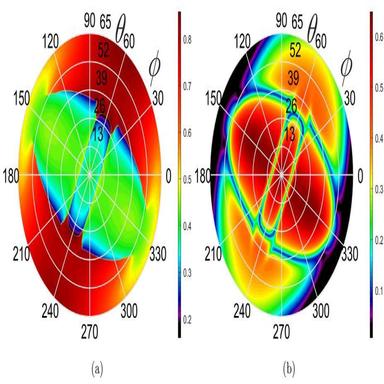
TOF P-UPS plot(a) and amplitude P-UPS plot(b) corresponding to a measurement on a unidirectional 4 C/E plate (d = ± 1.200 0.006 mm). The TOF colorbar is represented in μs. The amplitude colorbar is normalized to the maximum amplitude of the input signal.